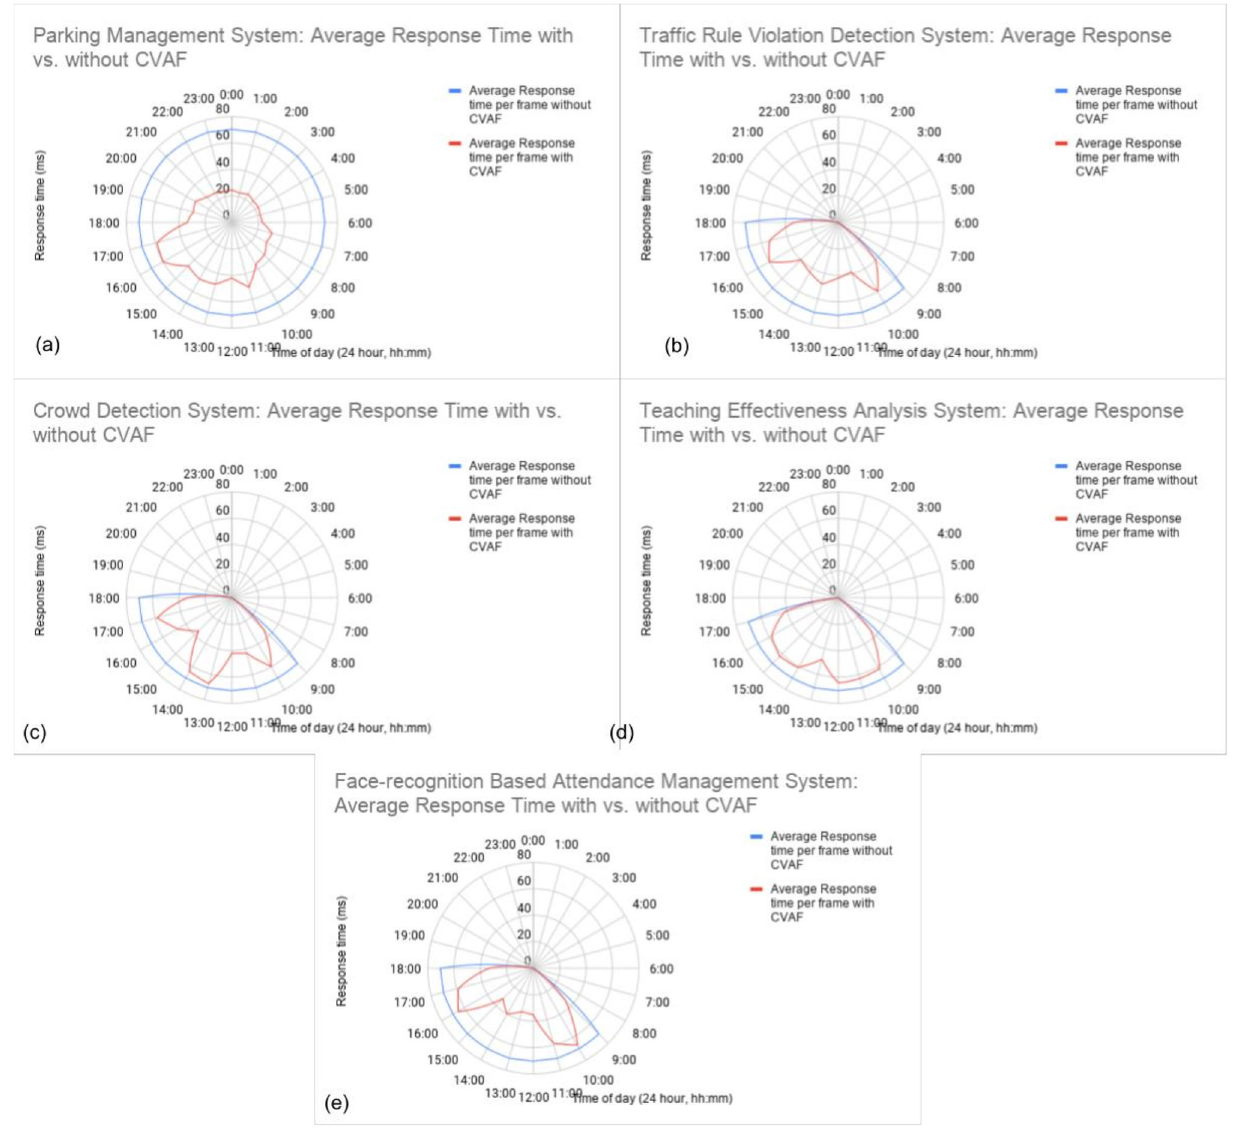
Fig. 9 Average response times for different applications deployed with and without CVAF over 24h. a Parking management, system, b traffic rule violationdetectionsystem, c crowddetectionsystem, d teachingeffectivenessanalysissystem,and e face-recognition-basedattendancemanagement system